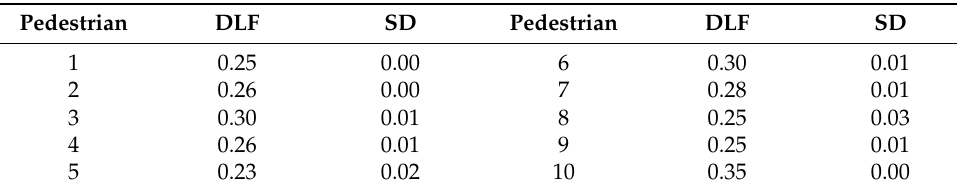
Table 3. Calculated dynamic load factors (DLFs) of the test subjects.